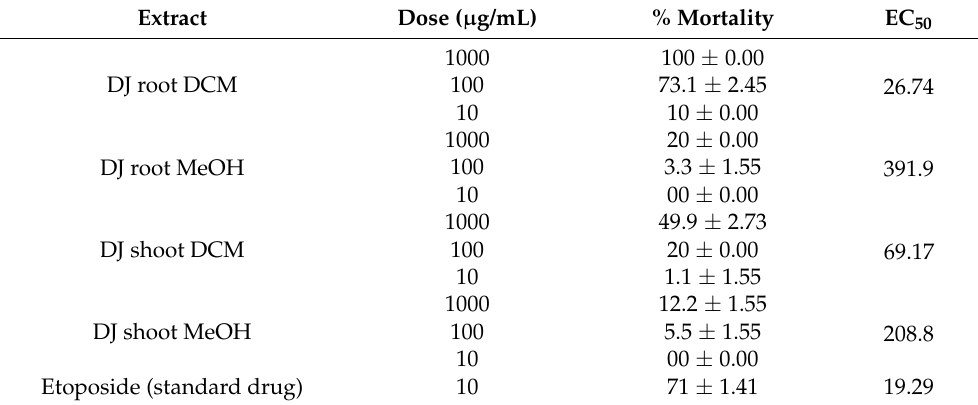
Table 4. Toxicity assessment of various D. juxtapostia crude extracts using a brine shrimp lethality assay. Extract Dose ( µ g/mL) % Mortality EC 50 1000 100 ± DJ root DCM